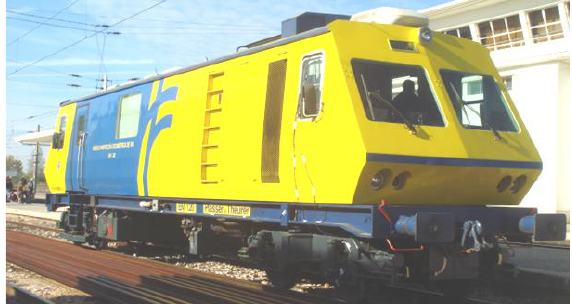
Figure 4. Track inspection vehicle EM 120 from IP.